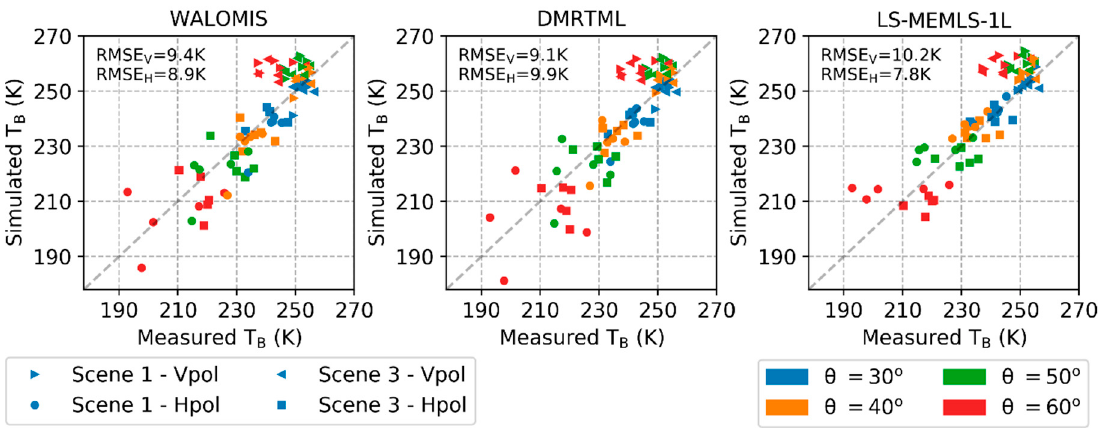
Figure 7. T B simulated from WALOMIS ( left ), DMRT-ML ( center ) and LS-MEMLS-1L ( right ) for Scene 1 and 3 at V-pol and H-pol (symbols) and at four incidence angles (colors). Table 2. Root-mean-square height (RMSE) of all the dates and Scene 1 and 3 together. “All” is the RMSE calculated with incidence angles of 30 ◦ , 40 ◦ , 50 ◦ and 60 ◦ . RMSE for T B V-pol (K) RMSE for T B H-pol (K) 30 ◦ 40 ◦ 50 ◦ 60 ◦ All 30 ◦ 40 ◦ 50 ◦ 60 ◦ All